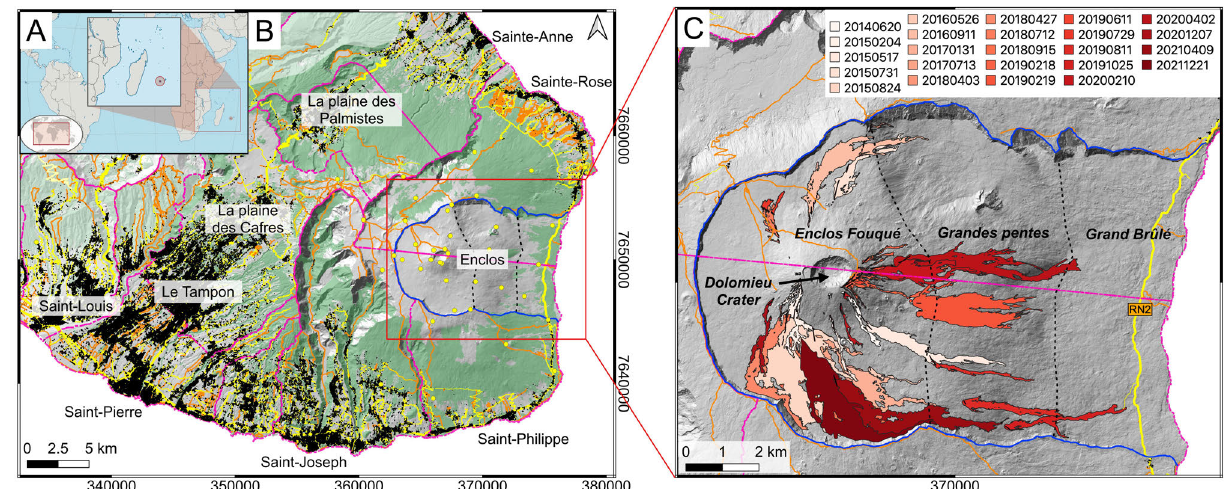
Figure 1: Location of Piton de la Fournaise and its lava flows since 2014. [A] Location of La Réunion island (credits Wikimedia Commons, the free media repository). [B] Map of Piton de la Fournaise showing the municipalities outline (pink dashed lines) and towns (buildings are in black), roads (yellow lines), trails (orange lines), the vegetated areas (in green) and the limits of the Enclos caldera (blue line). The background is a hill-shaded DEM released in 2010 (coordinates are given in meters within system WGS84-UTM 40S) by the Institut national de l’information geographique et forestiere (IGN). Buildings, roads, and trails are from 2019 BD TOPO® IGN. Yellow dots are the volcano observatory monitoring stations. [C] Zoom of the Enclos showing the fissures (black lines) and associated lava flows (color coded) since 2014 and up to early of 2022 (legend indicates the eruption starting date: YYYYMMDD). The dashed black lines divide the Enclos into three main domains: Enclos Fouqué Caldera, Grandes Pentes, and Grand Brûlé. Black arrow shows the summit Dolomieu